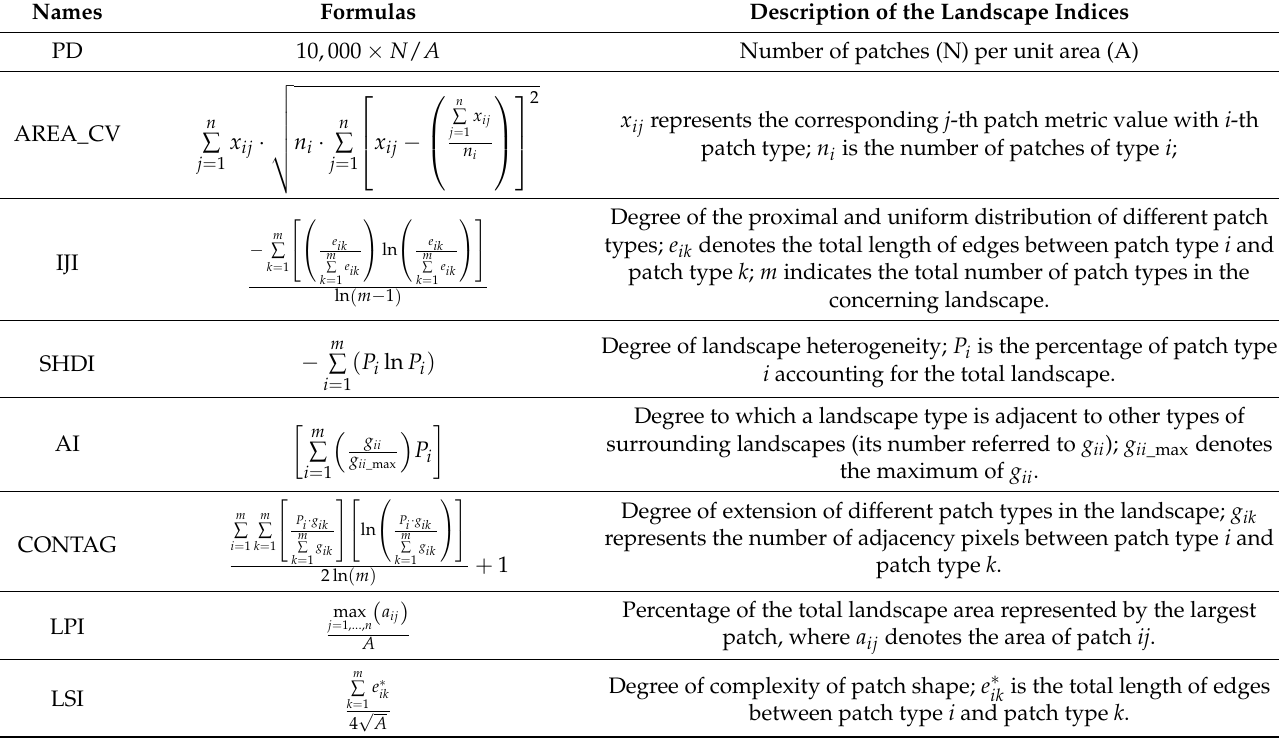
Table 3. Formulas for the landscape indices and their description.